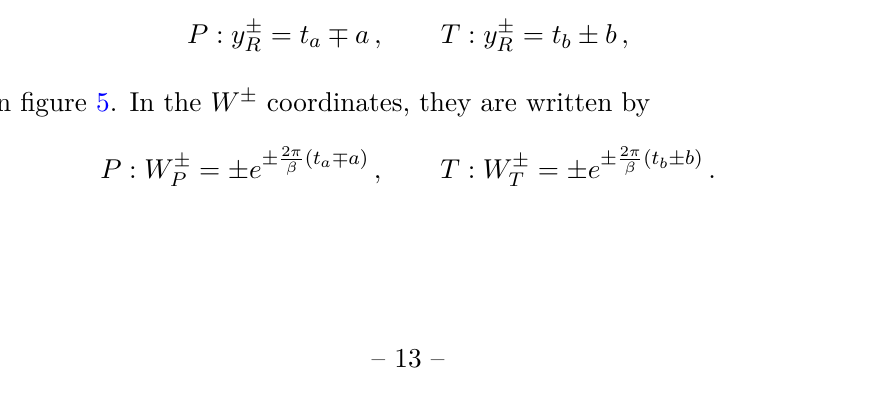
, y ± as the shaded regions. R L